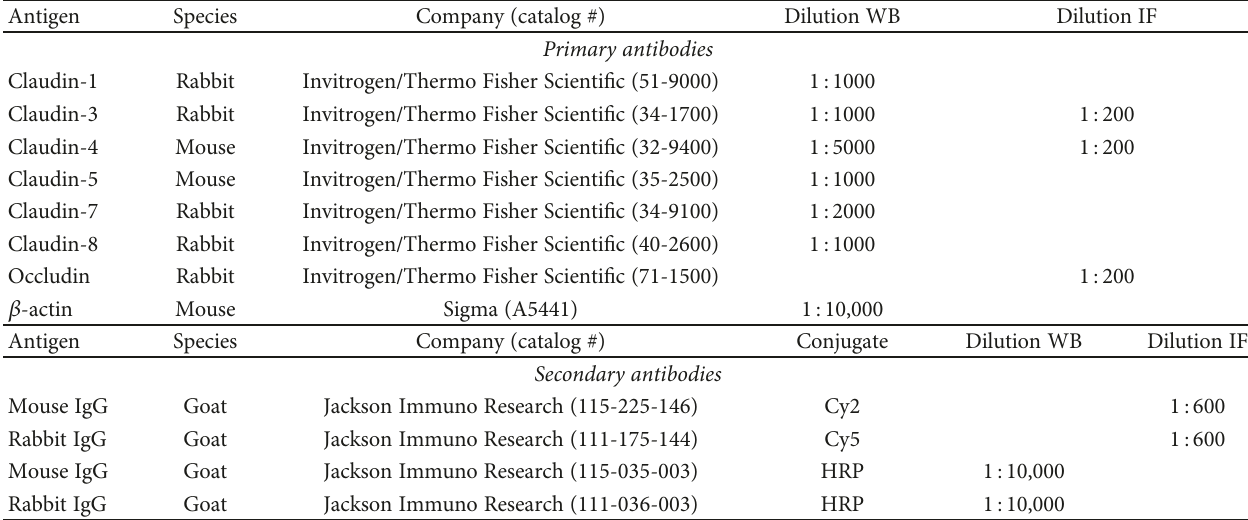
Table 2: Primary and secondary antibodies (WB=Western blot, IF = immuno fl